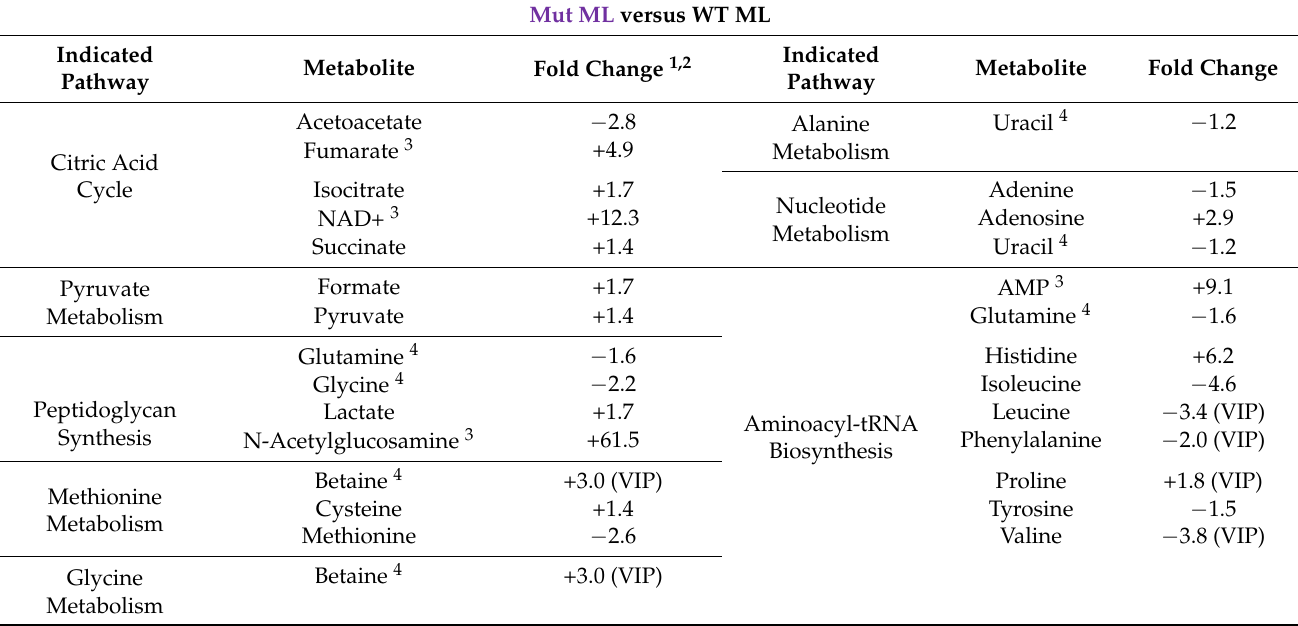
Table 2. Fold change of statistically significant metabolites in their corresponding metabolic pathways for the mid log phase of mutant versus wild